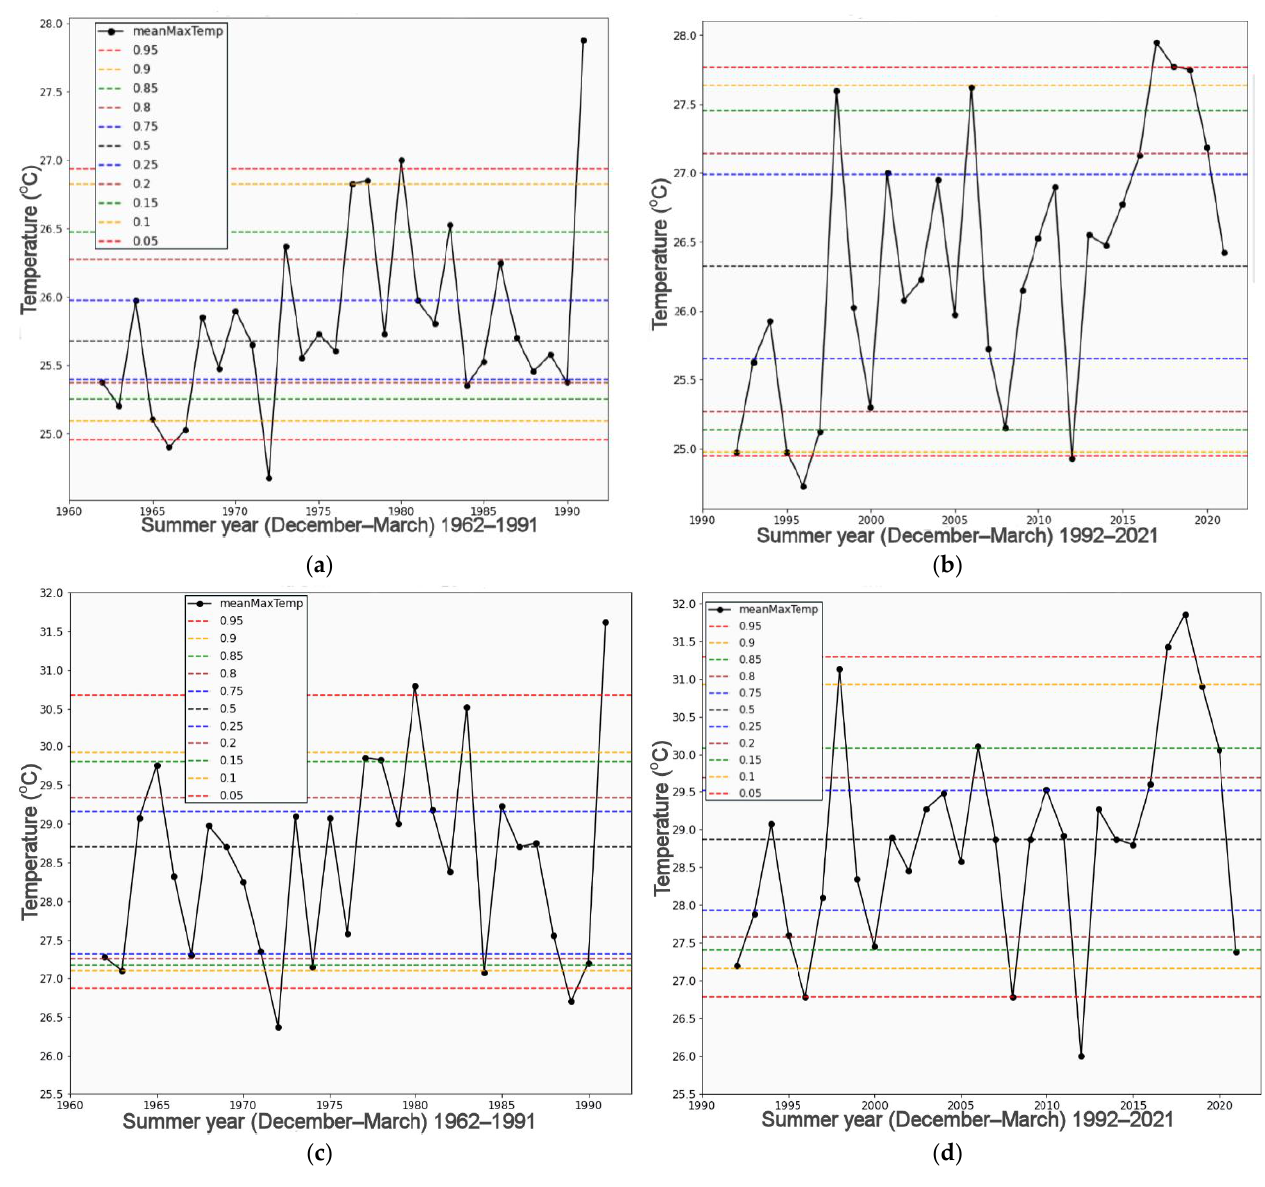
Figure 2. ( a ) Sydney (Observatory Hill) mean maximum temperature for summer (December–March) 1962–1991, ( b ) as in ( a ), except for 1992–2021, ( c ) Richmond mean maximum temperature for summer (December–March) 1962–1991, ( d ) as in ( c ), except for 1992–2021. The solid black line is the average of the mean maximum temperature for the summer months. The dotted lines show the 5th and 95th percentiles (bottom and top red), 10th and 90th (bottom and top yellow), 15th and 85th (bottom and top green), 20th and 80th (bottom and top brown), 25th and 75th (bottom and top blue), and 50th percentiles (middle black) for each climate period.